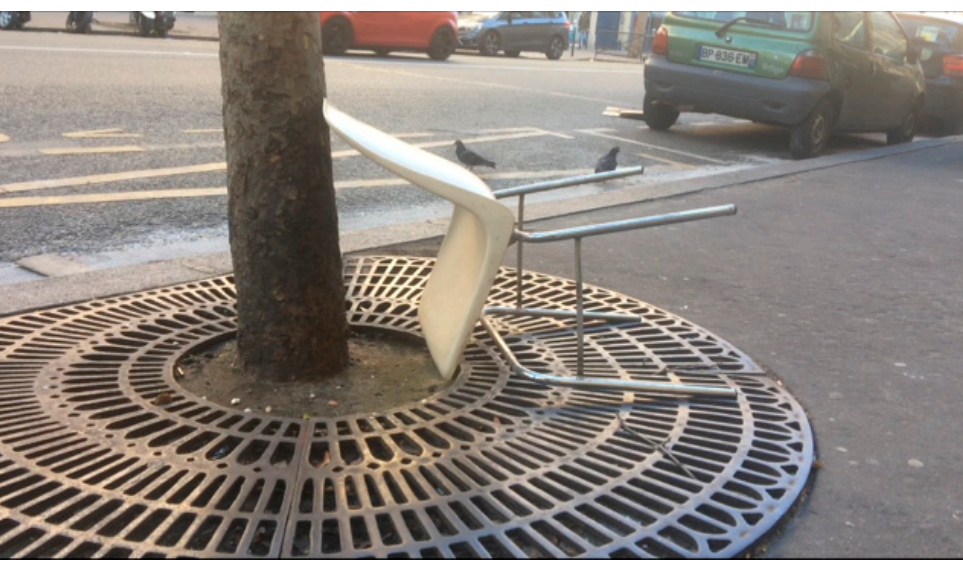
Figure 1. Abandoned chair seen on Boulevard Voltaire, 11ème arrondissement in Paris, 2017.